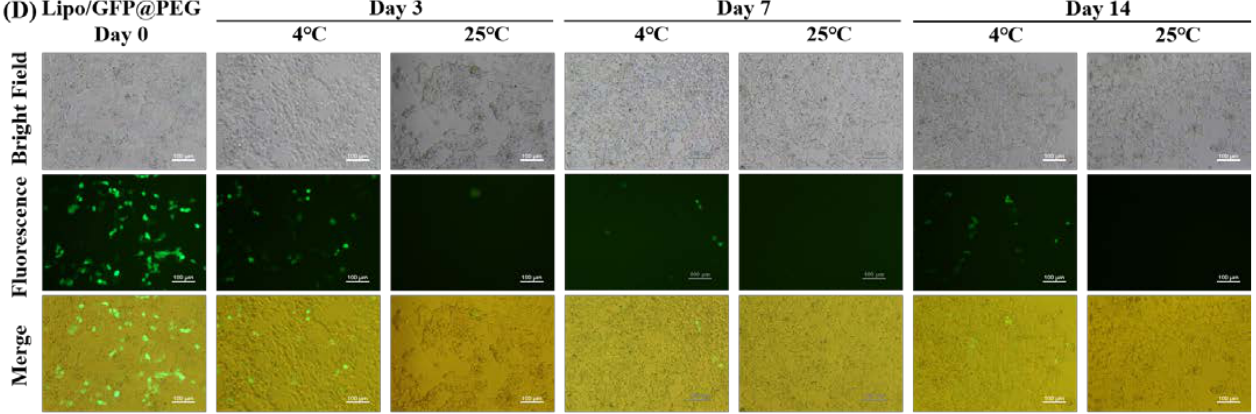
Figure 5. Transfection stability assay of 293T cells treated with PEI/GFP ( A ), PEI/GFP@PEG ( B ), Lipo/GFP ( C ), and Lipo/GFP@PEG ( D ).